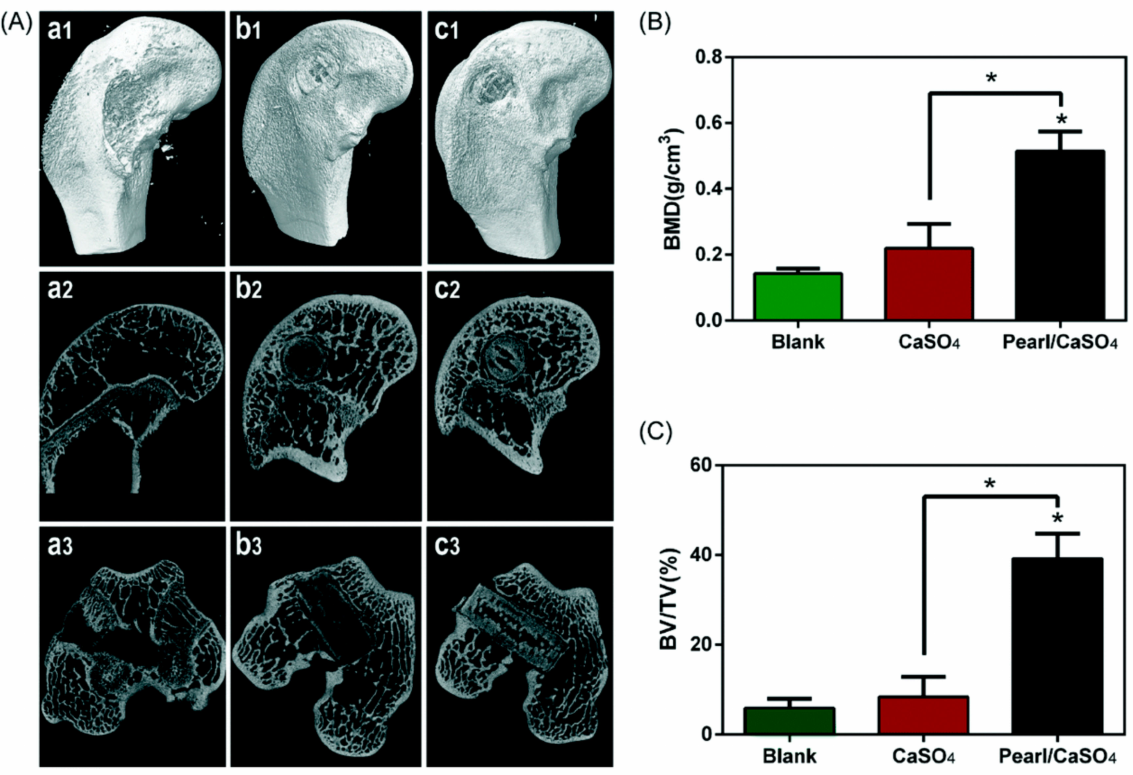
Figure 6. Post-implantation evaluation of repaired skulls. ( A ) 3D images of (a1–a3) control, (b1–b3) scaffolds from CaSO 4 , and (c1–c3) scaffolds from pearl/CaSO 4 ; morphometric analysis of ( B ) bone mineral density, and ( C ) bone volume/total volume. Reproduced from [79]. * p <